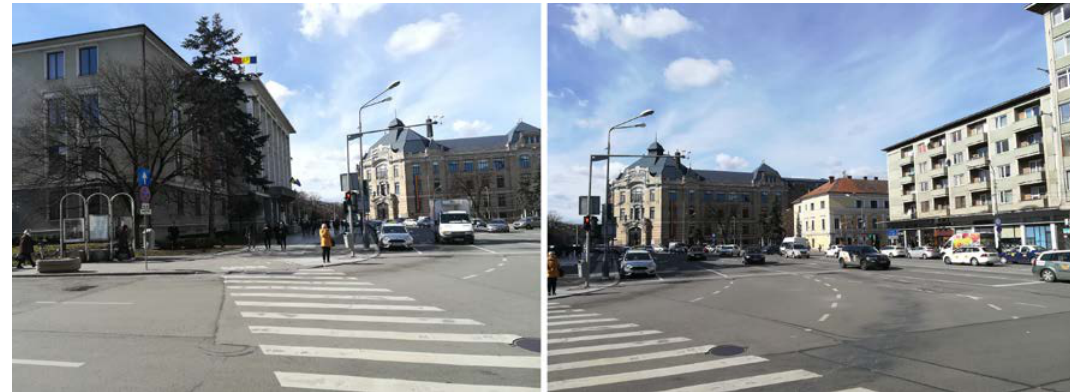
Figure 11: Lucian Blaga Square Source: Alexandru- Sabin NICULA,